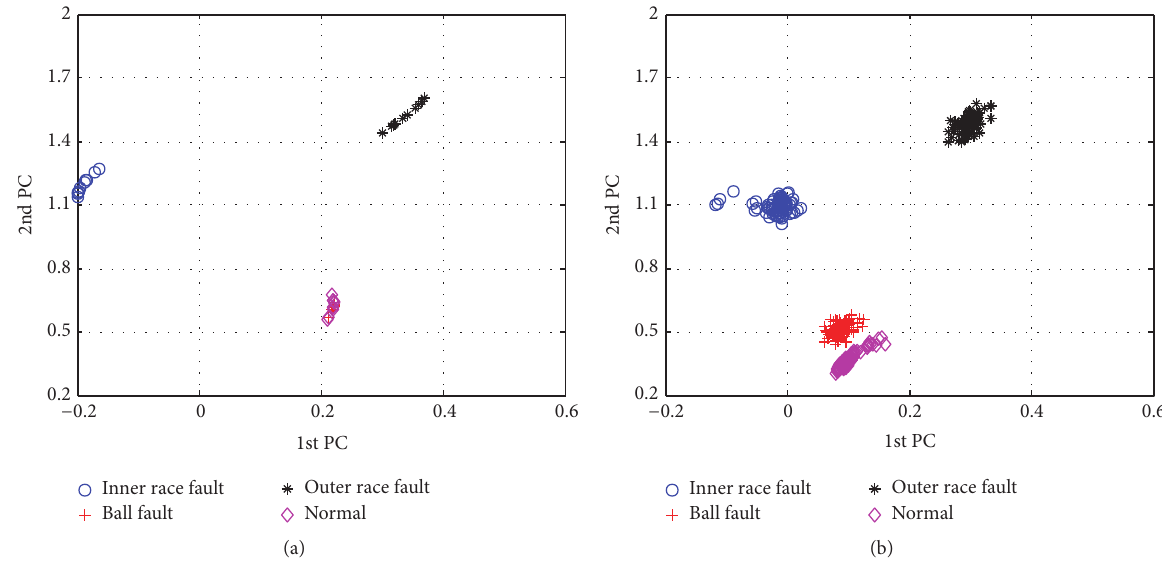
Figure 8: Feature extraction with RKMFA: (a) training set and (b) testing set.